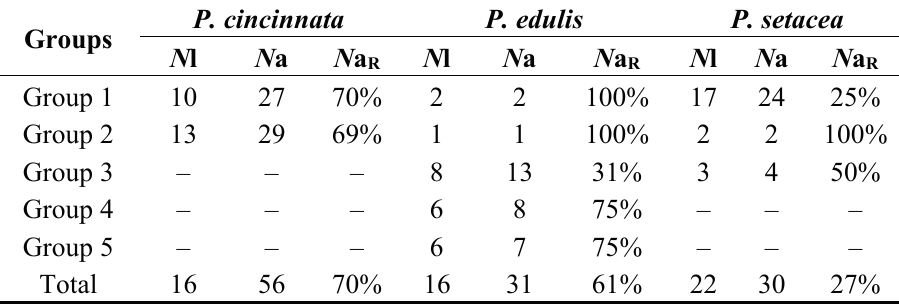
Table 3. Number of microsatellite loci with private alleles ( N l), the total number of these alleles ( N a) and the percentage of rare alleles ( N a R ) identified in each genetic group, as estimated based on Bayesian analyses of three passion fruit